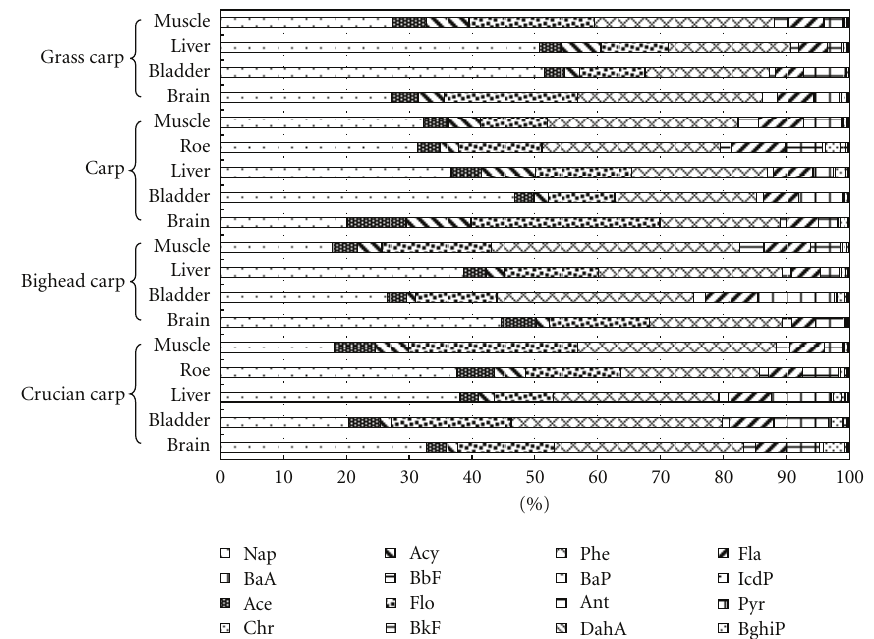
Figure 1: Percentage composition of 16 priority PAHs congeners in the fish from Beijing